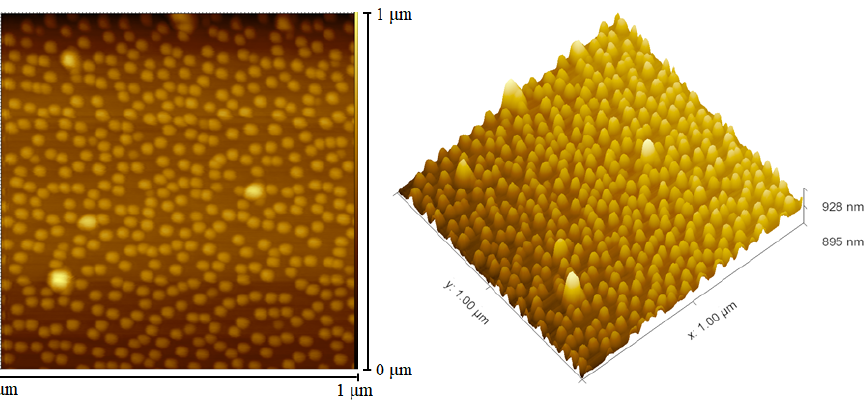
Figure 5. An AFM scanning image of uncapped InAs QDs (1 × 1 μm 2 ) .